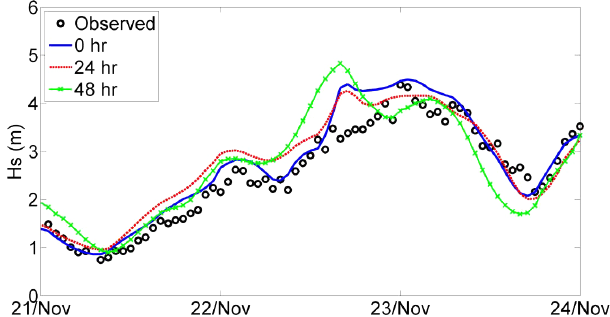
Figure 14. Significant wave height H s for different HIRLAM input: blue – analyzed; red – 24h forecast; green – 48h forecast; black circles – buoy. Location: K13